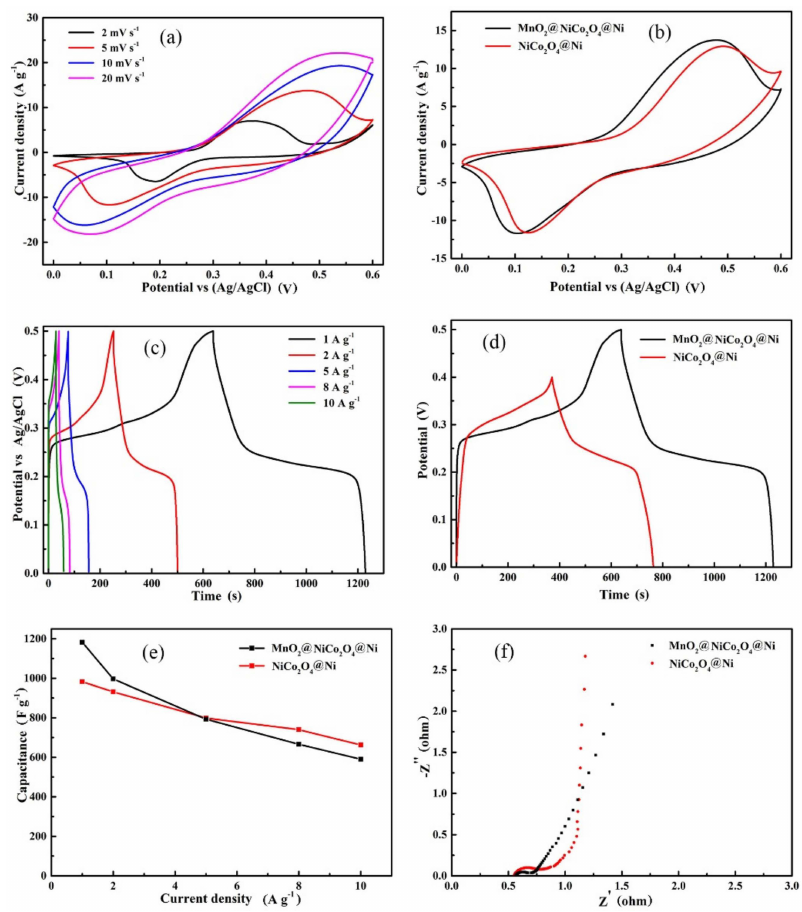
Figure 6. ( a ) Cyclic voltammetry (CV) curves of MnO 2 @NiCo 2 O 4 @Ni under various scan rates, ( b ) CV curves of MnO 2 @NiCo 2 O 4 @Ni and NiCo 2 O 4 @Ni electrodes at 5 mV · S − 1 , ( c )